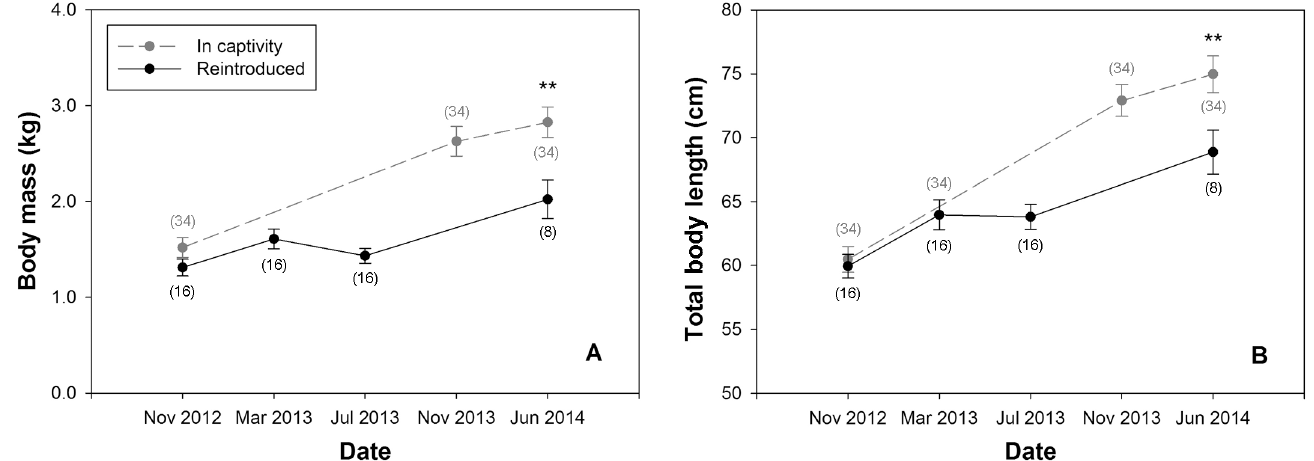
Fig 4. Comparison of body mass and total body length between reintroduced salamanders and their conspecifics in captivity. (A) Body mass comparison. (B) Total body length comparison. The 16 salamanders reintroduced to the Donghe River were from a group of salamanders whose growth was monitored since 2012. They were compared with salamanders that remained in captivity during the entire study period (November 2012 – June 2014). Plotted values are means ± 1 SE; ** indicates different values between the two groups at that particular time interval ( P < 0.01); numbers in parentheses indicate sample size.